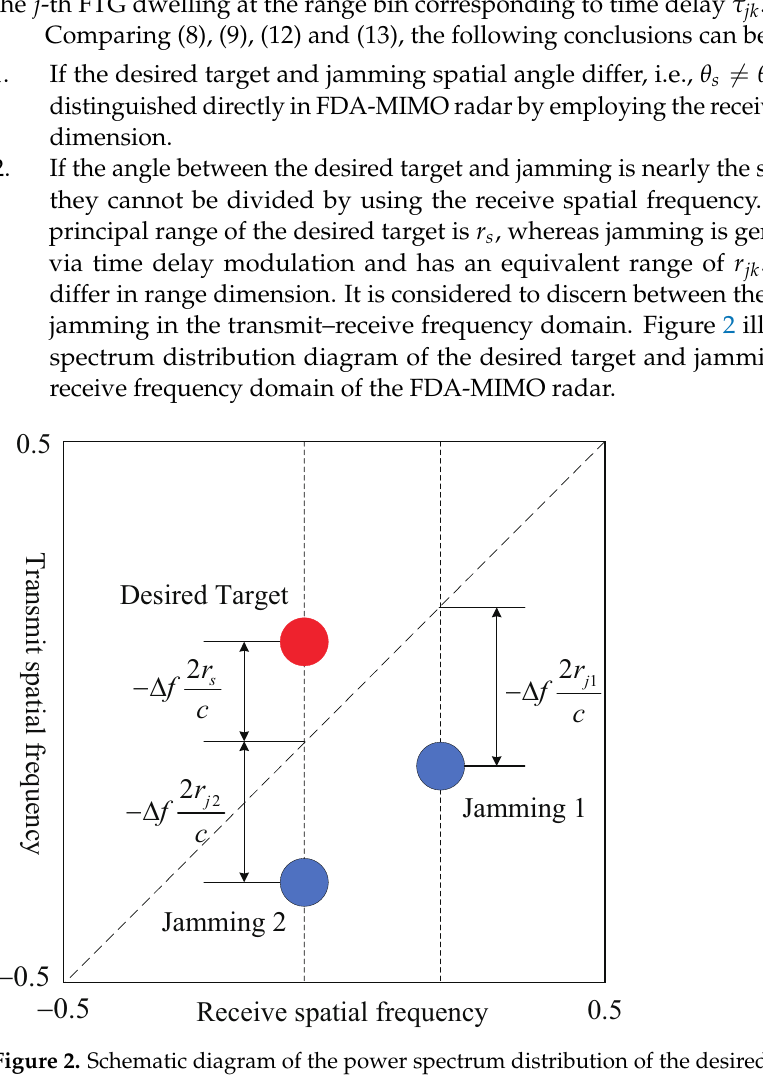
Figure 2. Schematic diagram of the power spectrum distribution of the desired target and